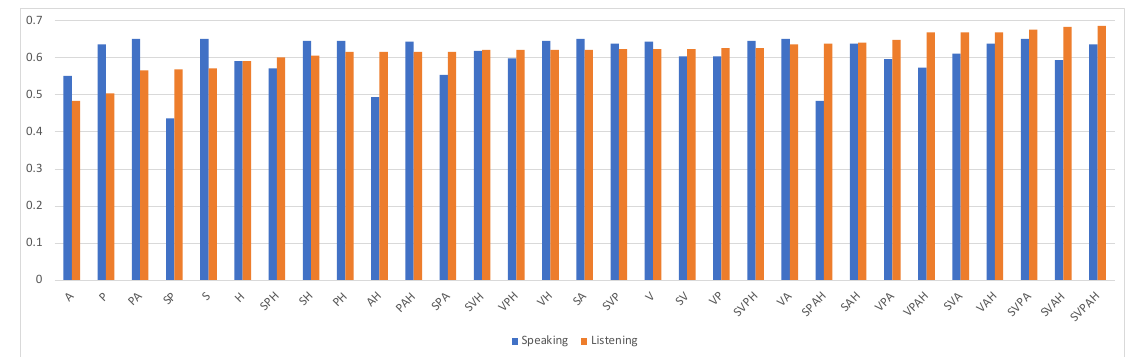
Figure 7. F-measure values (vertical axis) showing the performance of the nodding prediction models in speaking and listening situations for all 31 possible combinations of feature sets: the bars are sorted in the order of the performances of listening models.